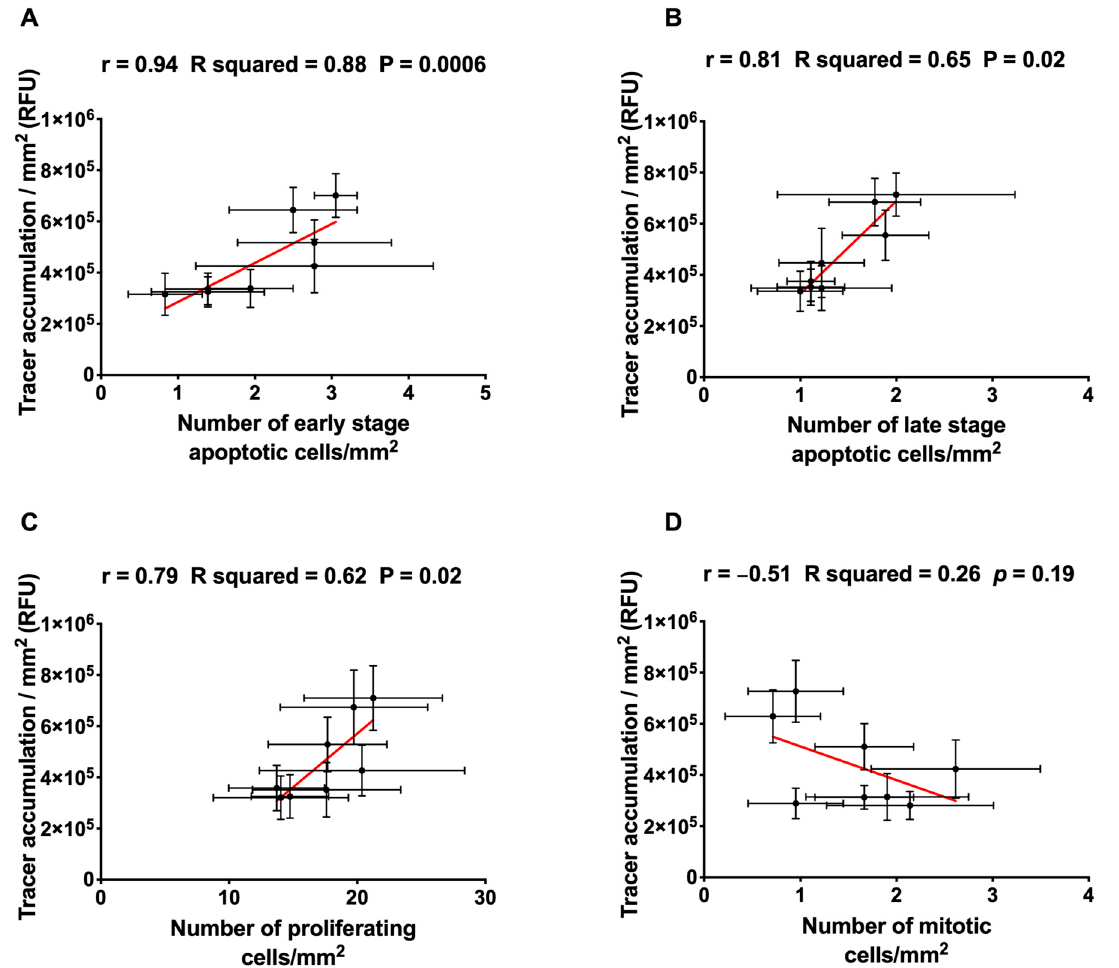
Figure 3. Correlation between tracer accumulation and the corresponding number of ( A ) early-stage apoptotic cells, ( B ) late-stage apoptotic cells, ( C ) proliferating cells and ( D ) mitotic cells under shear. Pearson correlation coefficient (r), R squared and p -value are shown above each graph. Each point represents the mean ± SEM at one radial location ( n = 5 isolations).